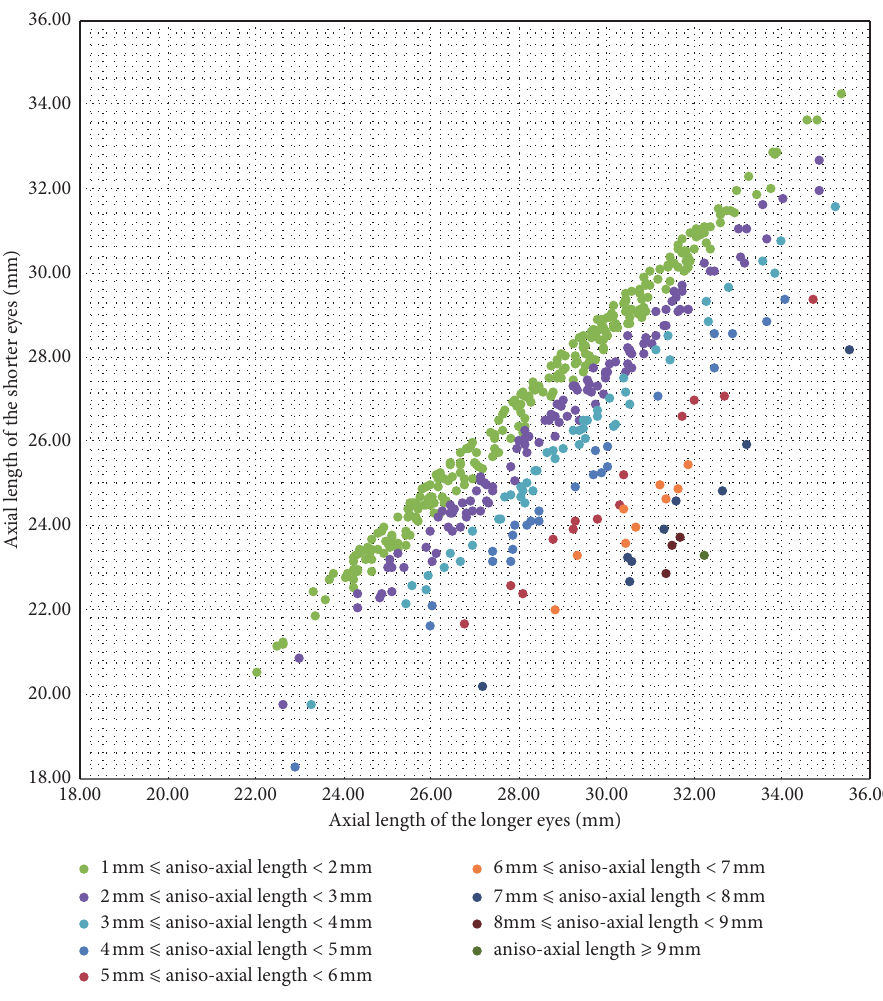
Figure 1: Distributions of the binocular axial lengths of 505 aniso-axial length patients. Every dot in the figure represents one person with a binocular axial difference ≥ 1mm. The horizontal axis indicates the axial length of the relative longer eye in each patient, and the vertical axis indicates the axial length of the relative shorter